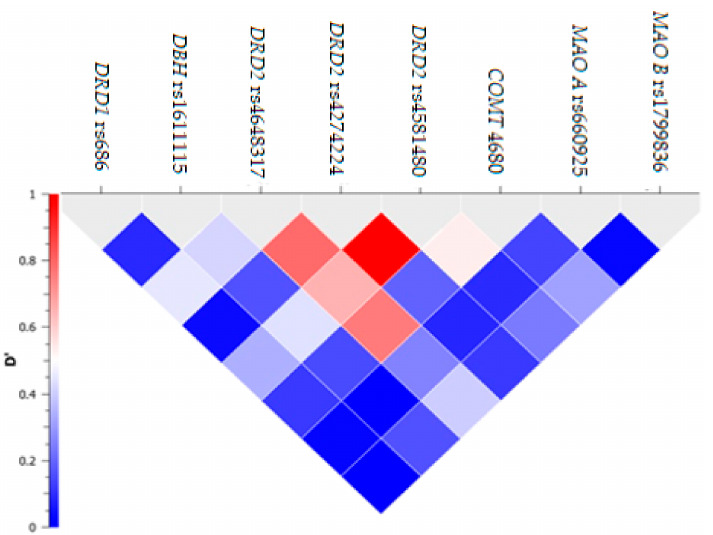
Figure 1. Linkage disequilibrium between selected single-nucleotide polymorphisms (SNPs). On y axis, D’ represents the coefficient of linkage disequilibrium between the tested SNPs (represented on x axis). DRD1 : dopaminergic receptor D1; DRD2 : dopaminergic receptor D2; DBH : dopaminergic beta hydroxylase; MAO B : monoamine oxidase B; MAO A : monoamine oxidase A; COMT : catechol O methyl transferase.